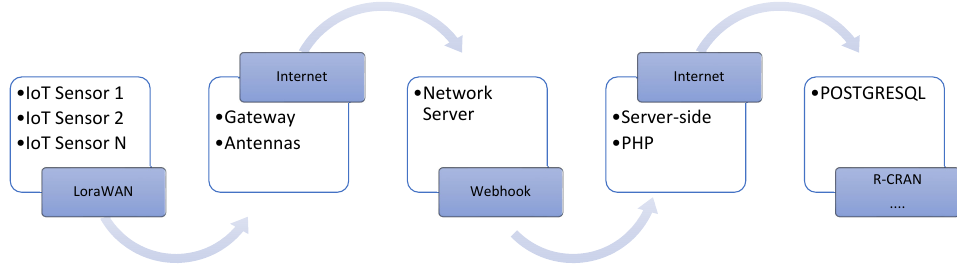
Figure 3. Schematic diagram of the flow of data from the sensor to storage and availability for further processing via R-CRAN or other programming environments.